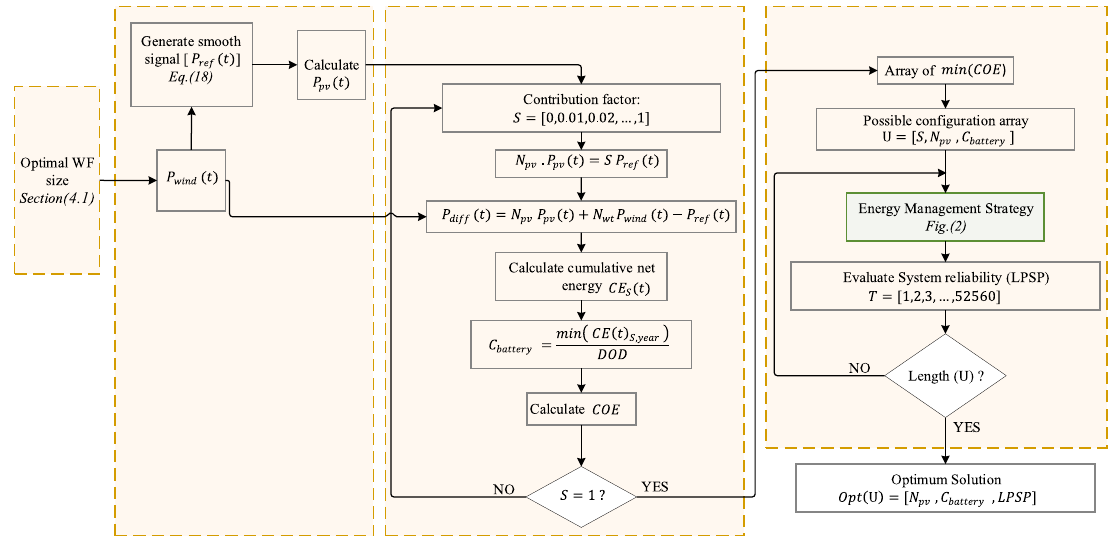
Figure 7. Flow chart for the proposed approach of